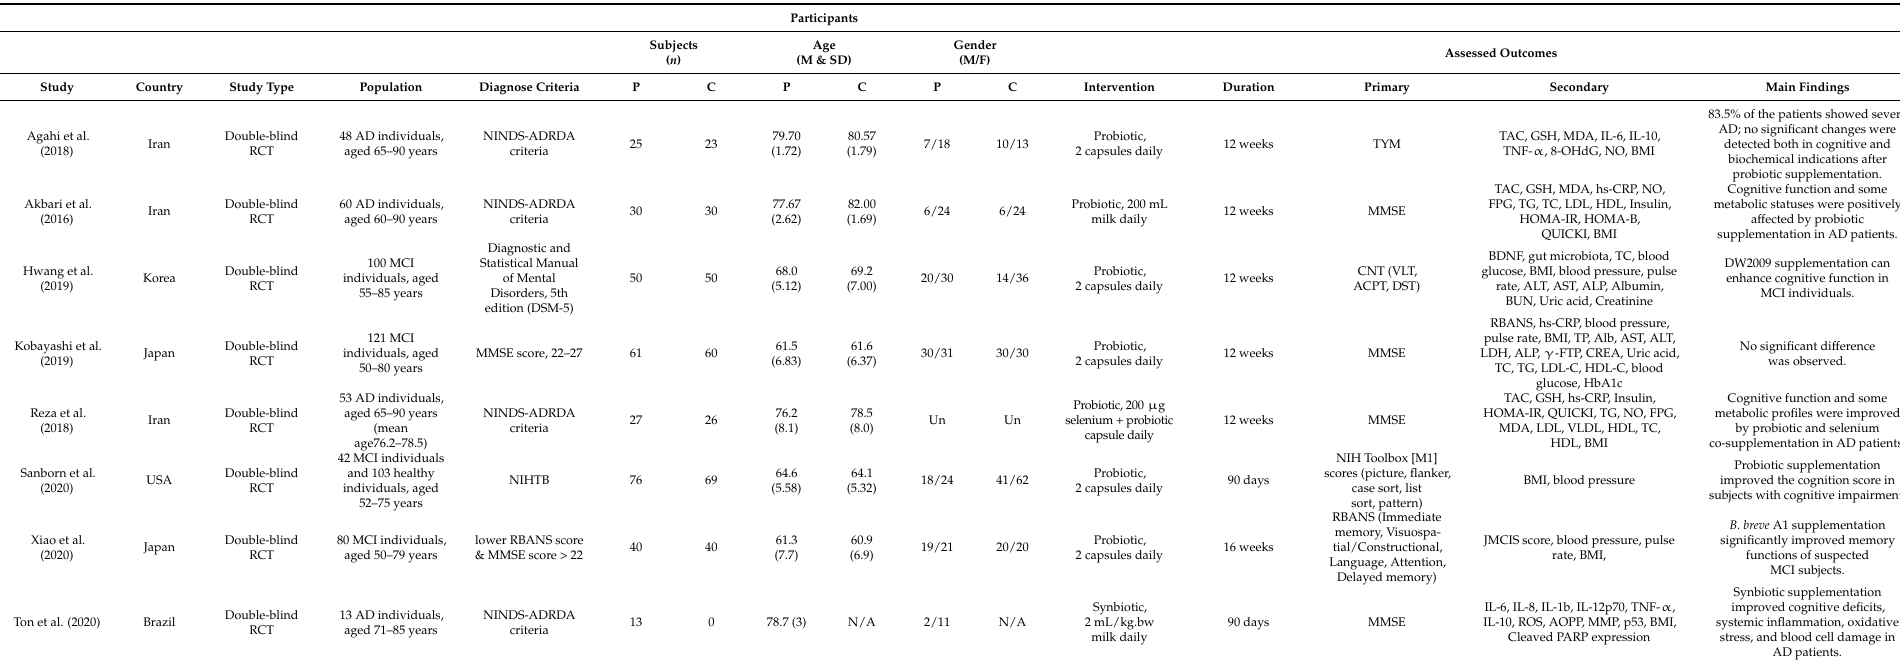
Table 2. Characteristics of the included studies.